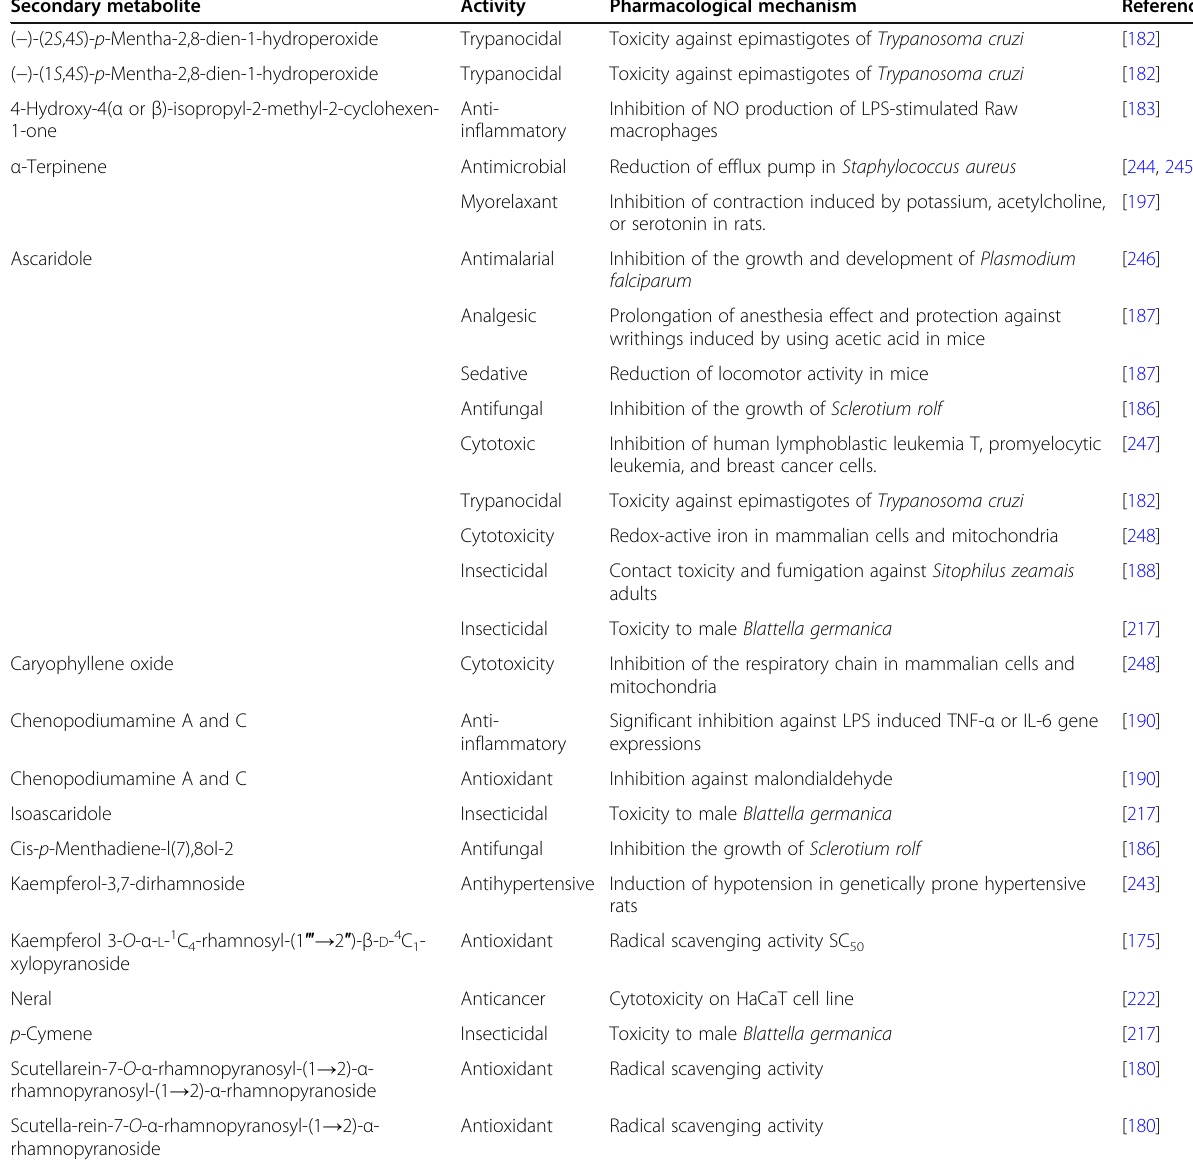
Table 4 Pharmacological properties of isolated compounds from C. ambrosioides